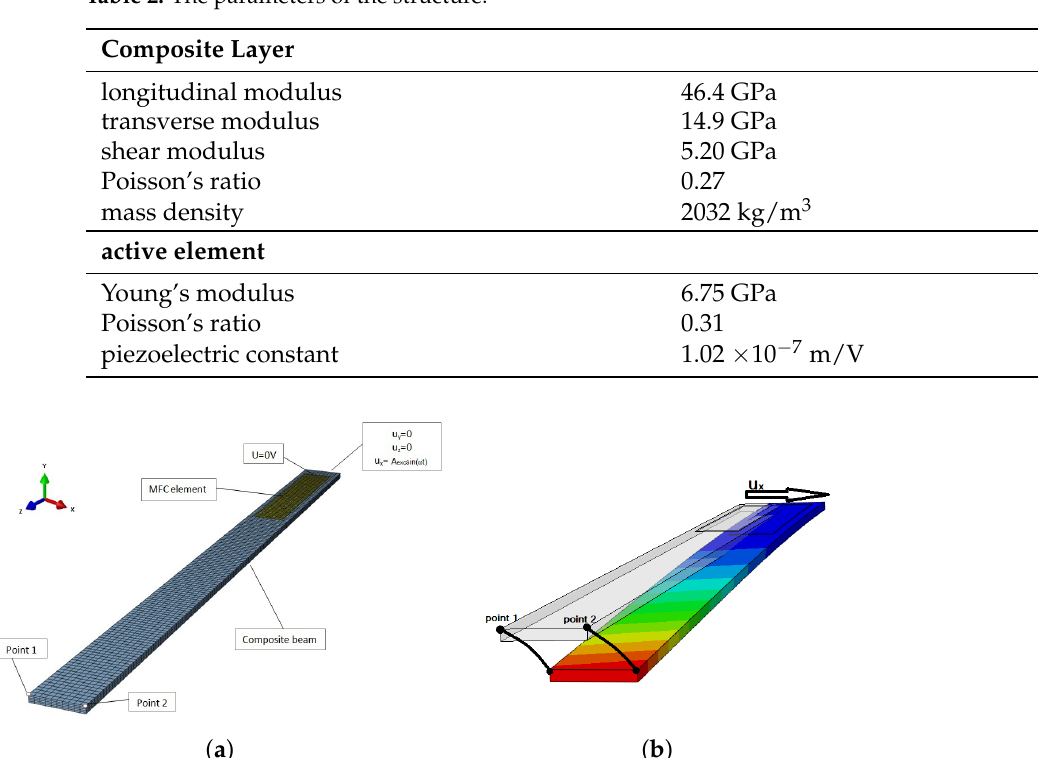
Figure 1. Finite Element (FEM) model of the beam with the piezoelectric element ( a ); beam deformations in flexible direction by excitation in stiff direction u x at chosen configuration of layers ( b